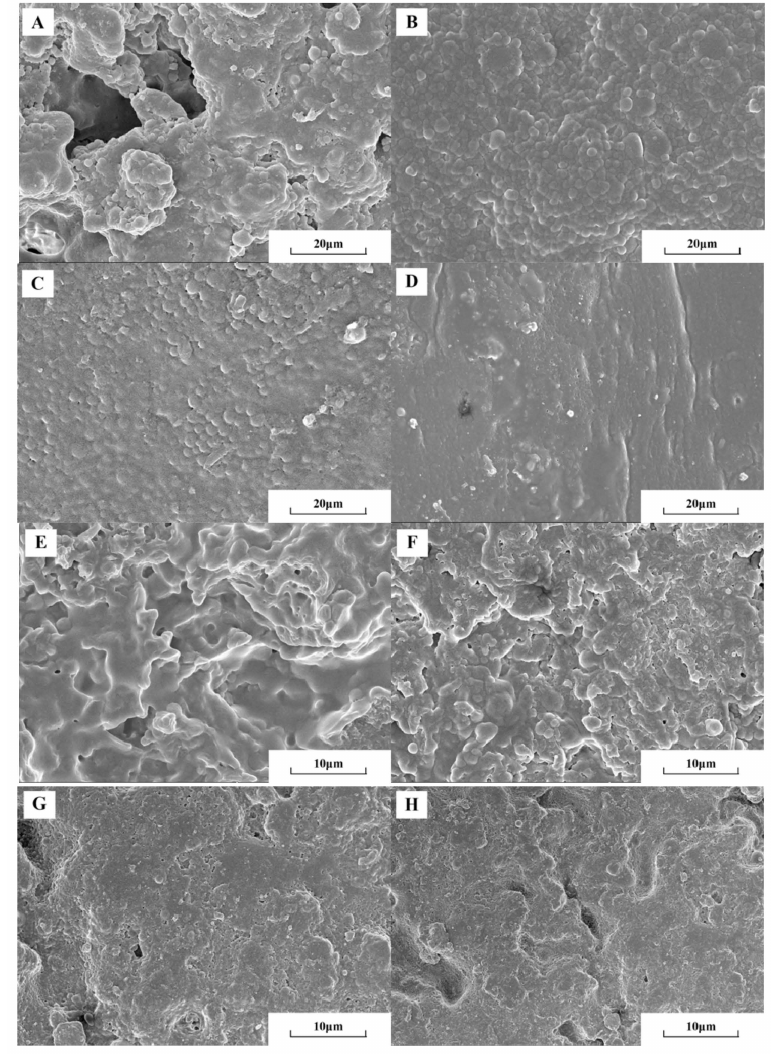
Figure 6. Scanning electron microscopy (SEM) micrographs of the surface and section of the flame-retardant coating. ( A ), ( B ), ( C ), and ( D ) were SEM of the surface of EP0, EP1, EP2, and EP5; ( D ), ( F ), ( E ), and ( G ) were SEM of the section of EP0, EP1, EP2, and